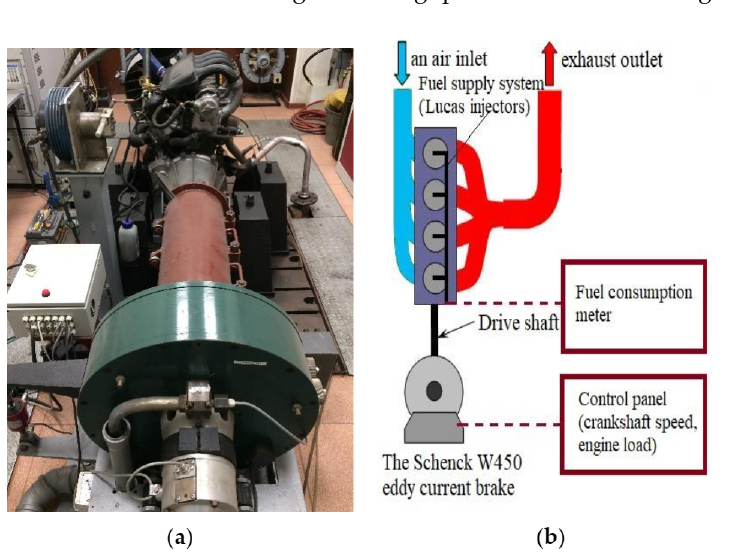
Figure 1. The research stand: XUD9A engine ( a ) and scheme of research stand ( b ). The torque measurement error on our dynamometer controlled by the Schenck system was ± 3 Nm, with a rotational speed of ± 5 rpm. The Laminar flow meter-measuring accuracy was ± 1%, and the differential pressure gauge when the measuring element temperature differed from the reference temperature (+20 ◦ C), with a max. ±